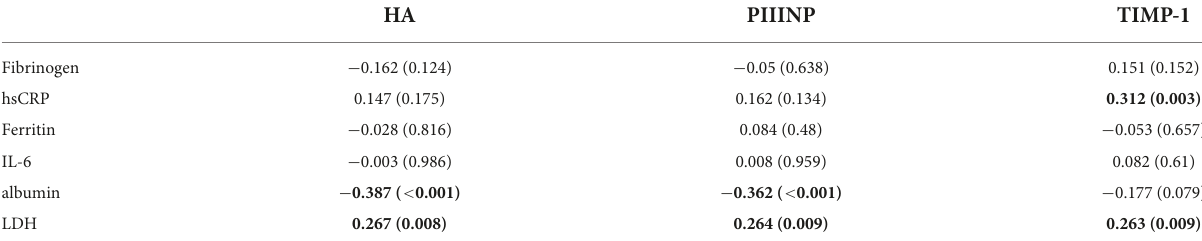
TABLE 3 Correlation among procollagen type III amino terminal propeptide (PIIINP), Hyaluronic acid (HA), and tissue inhibitor of metalloproteinases 1 (TIMP-1) with inflammatory markers. HA PIIINP TIMP-1 Fibrinogen − 0.162